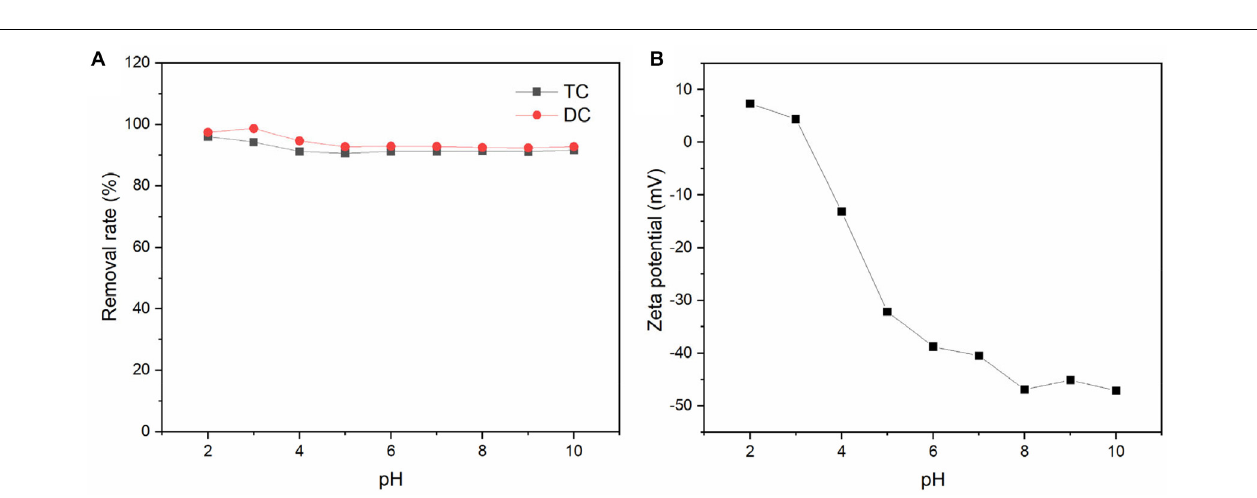
K F is the Freundlich constant (L · mg − 1 )